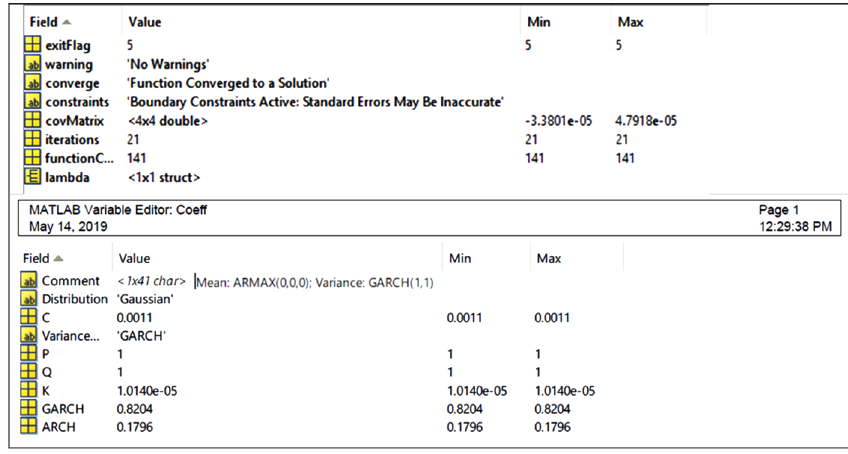
Figure 12. Results of applying the garchfit function in Matlab (data source: BVB. SIF1 closing quotations between 1/1/2000÷5/13/2019)